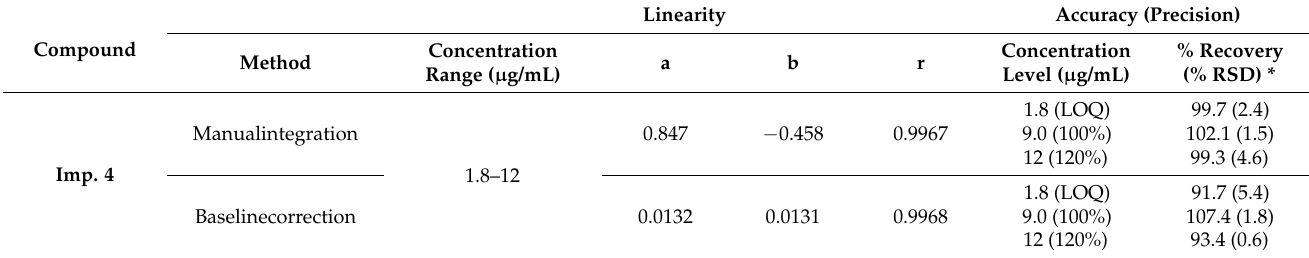
Table 1. Validation parameters: linearity and accuracy through baseline correction and integration through chromatographic